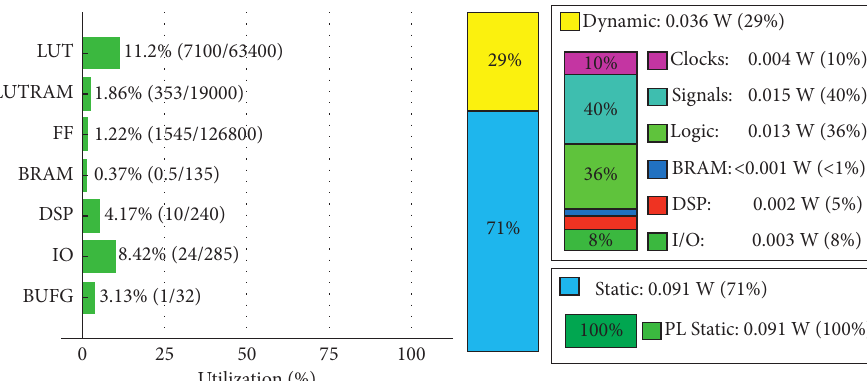
Figure 15: Resource utilization and power-consumption distribution in the field-programmable gate array